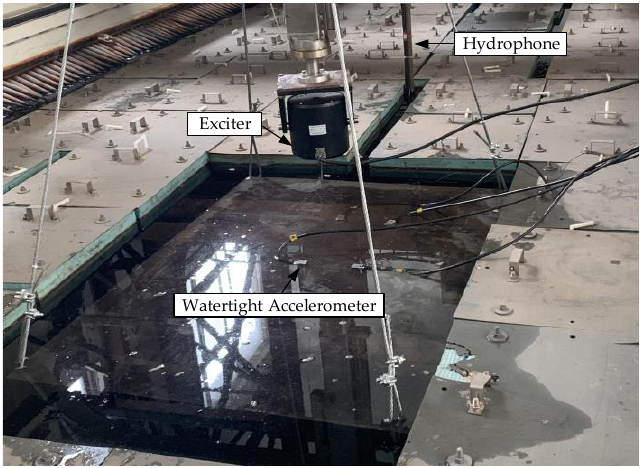
Figure 7. The actual experimental setup of the underwater vibration and sound radiation test.